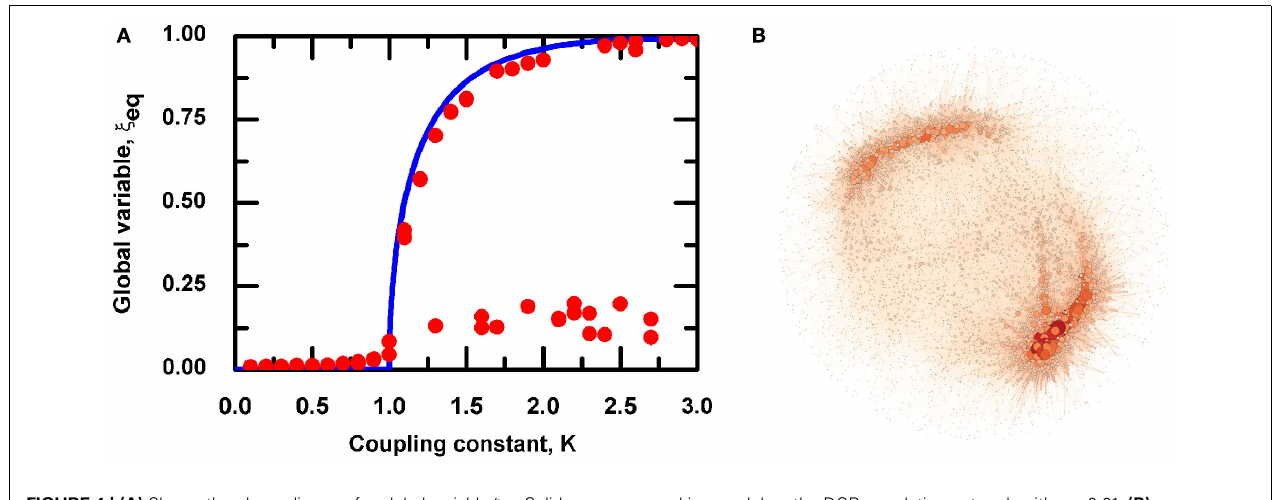
FIGURE 4 | (A) Shows the phase diagram for global variable ξ eq . Solid blue line corresponds to the equilibrium states obtained in the case of fully connected, infinite network ( N =∞ ). Dots correspond to the equilibrium states obtained by evaluating the dynamics of the decision